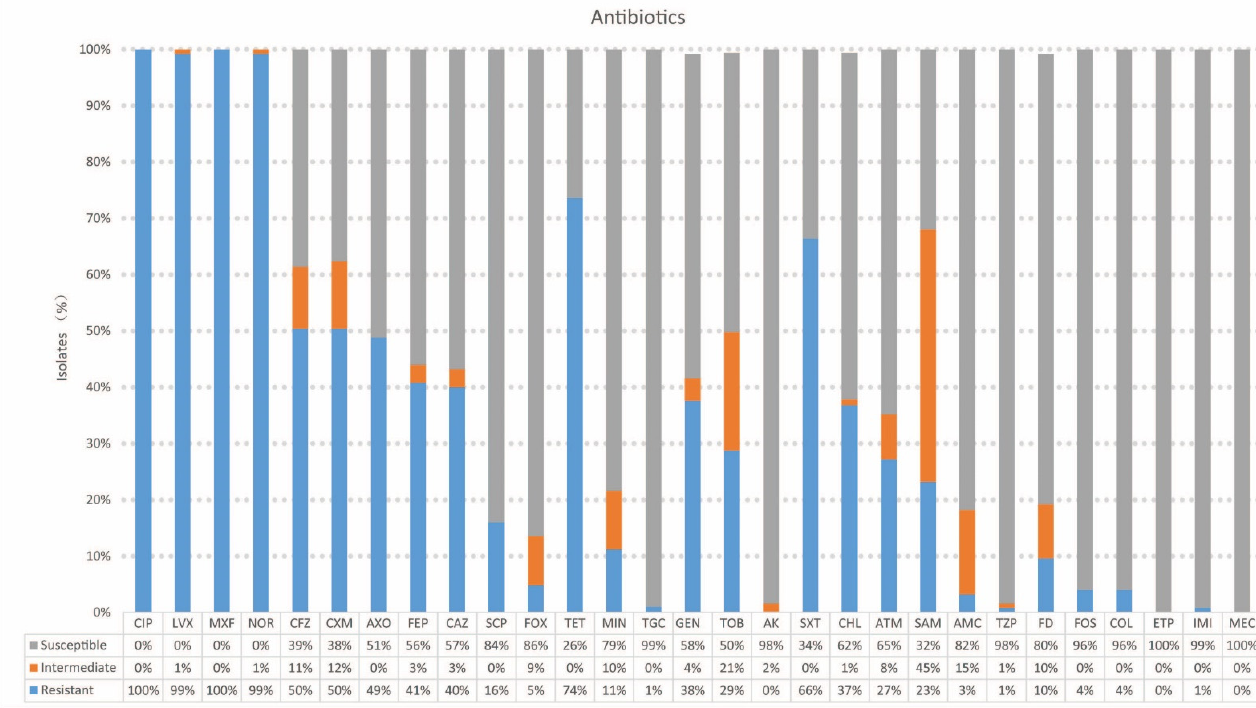
Table 1. PMQR gene combinations in 125 bacterial